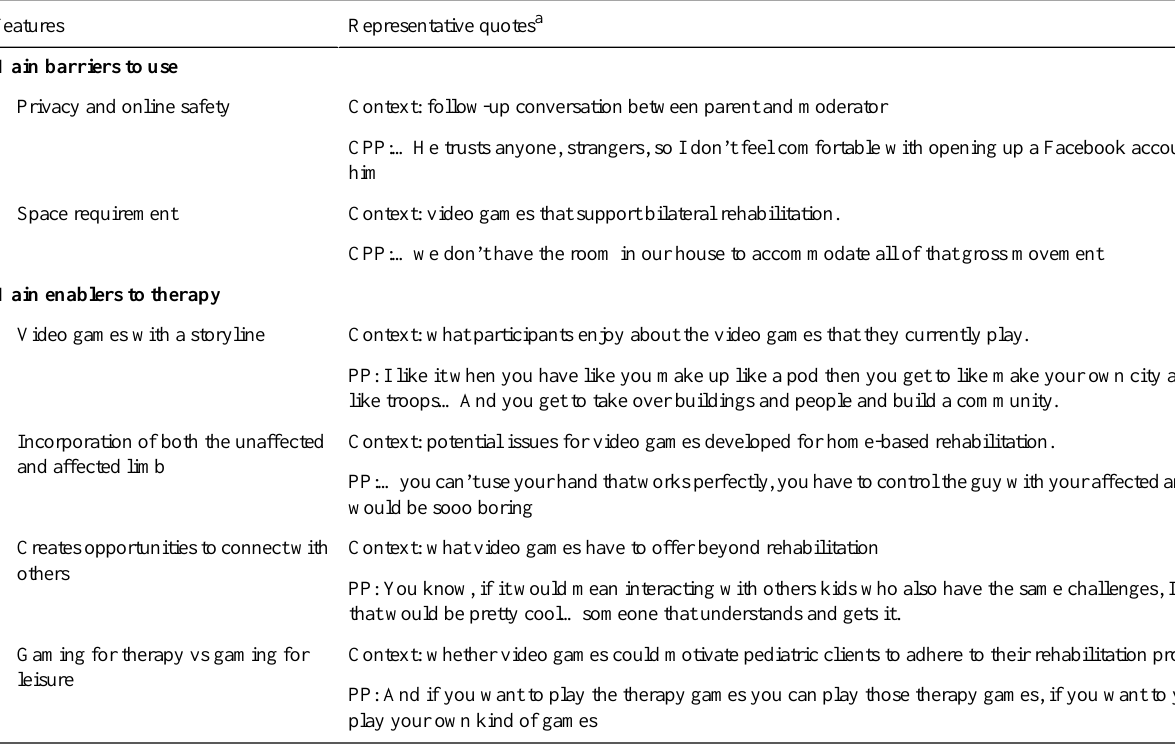
Table 3. Summary of main barriers to use and main enablers to therapy for pediatric focus group.